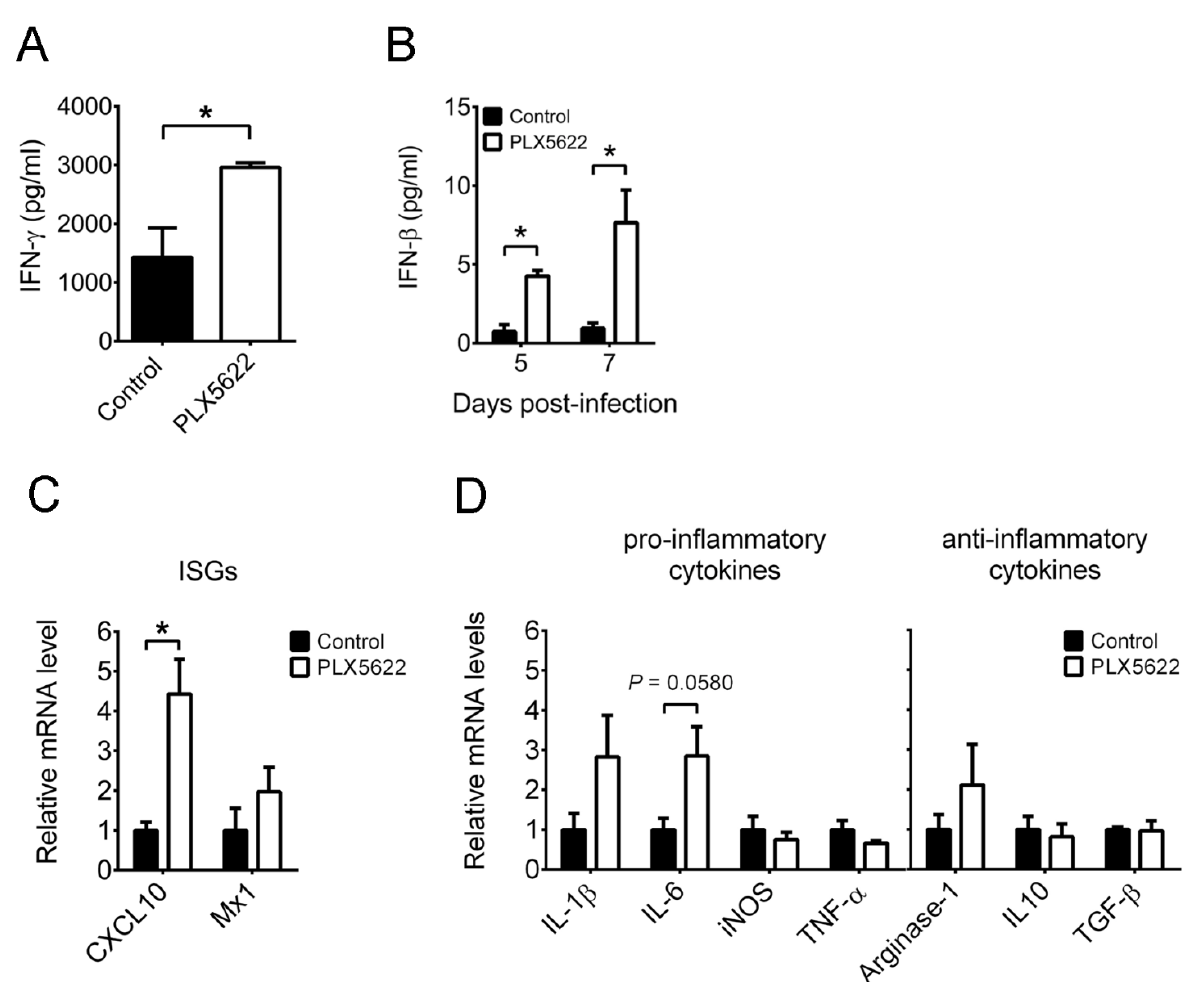
Figure 6. The effect of PLX5622 on the expression of immune modulators in brains of infected mice. Brains of infected mice fed with control chow or the chow containing PLX5622 were harvested, processed, and assayed by ELISA ( A , B ) and quantitative RT-PCR ( C , D ). The levels of ( A ) IFN- γ on day 7 post-infection and ( B ) IFN- β on the indicated days post-infection are shown. The mRNA levels of ( C ) IFN-stimulated genes (ISGs) and ( D ) pro-inflammatory as well as anti-inflammatory modulators on day 5 post-infection are shown. In panels ( C , D ), the data are expressed as the ratio of indicated mRNA normalized to β -actin mRNA, and the means of control groups were set as 1. The data represent means + SEM (error bars) of 4 – 5 samples per group. *, p < 0.05.